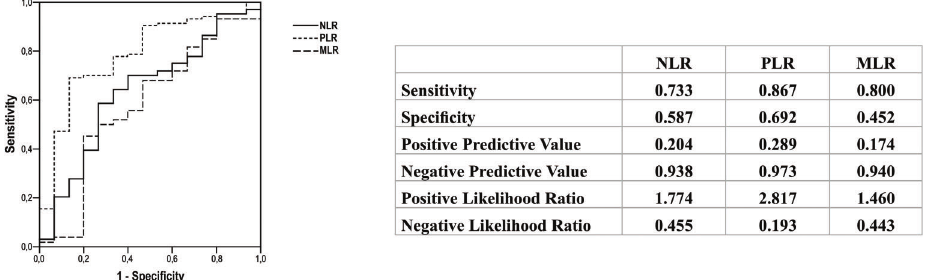
Figure 2 - Receiver operating characteristic curves showing the cut-off values of neutrophil–lymphocyte ratio (NLR), platelet– lymphocyte ratio (PLR), and monocyte–lymphocyte ratio (MLR) for discriminating distant metastasis from lymph node